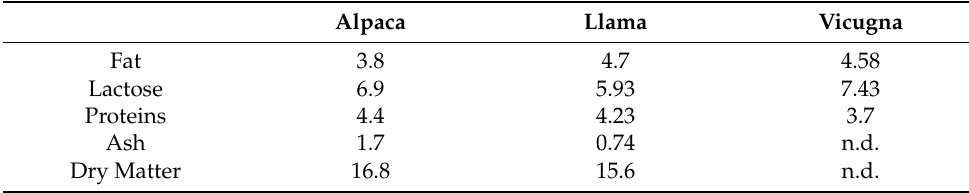
Table 2. Milk chemical composition in South American camelids (g/100